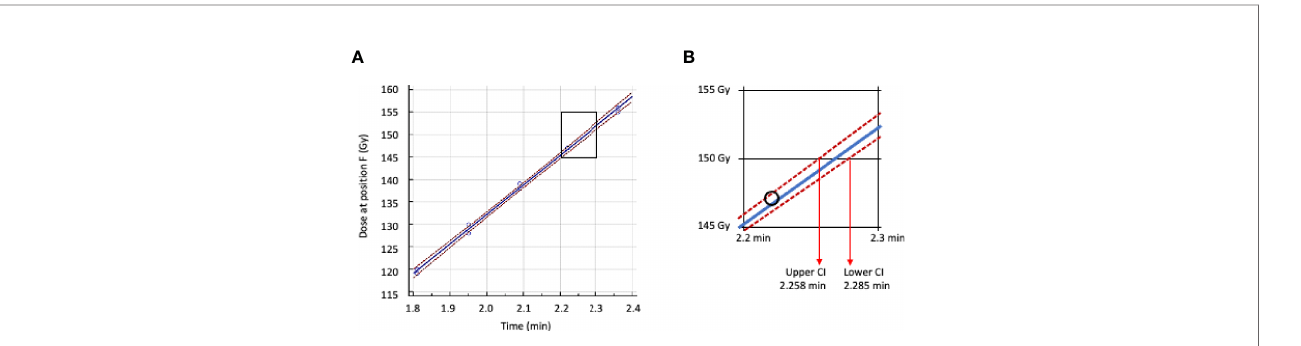
FIGURE 5 | Regression analysis of irradiation time vs dose received at location F (minimum dose location) inside the IMTC. (A) Regression line plot in blue, 95% con fi dence intervals in red. (B) Area in A between 145 Gy and 155 Gy enlarged with the lower and upper 95% con fi dence intervals. The time adopted for calculating the target dose of 150 Gy is 2.285 min.